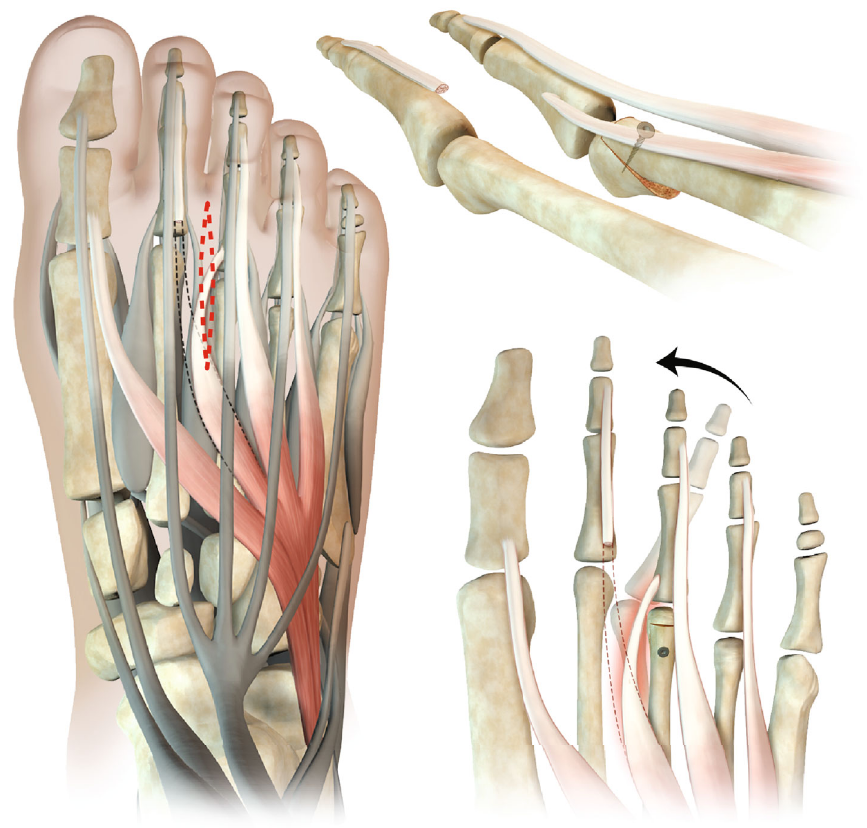
Figure 3: Schematic chart of the surgical procedure for splay toe correction: Modi fi ed Weil ’ s osteotomy with a lateral rotation of the metatarsal head. Extensor brevis tendon transfer from the second ray to the base of the proximal phalanx of the third toe.